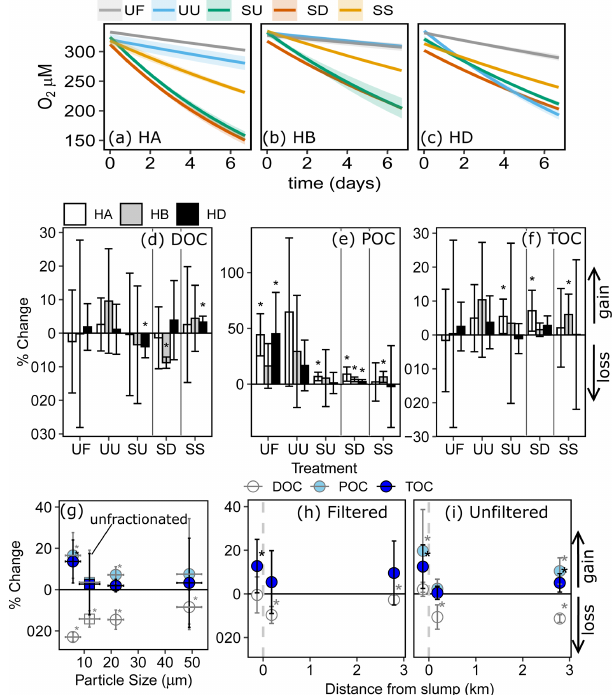
Figure 3. (a–c) Modelled (line) O 2 (mg L − 1 ) across combinations of source material and settling effects. Percent change in